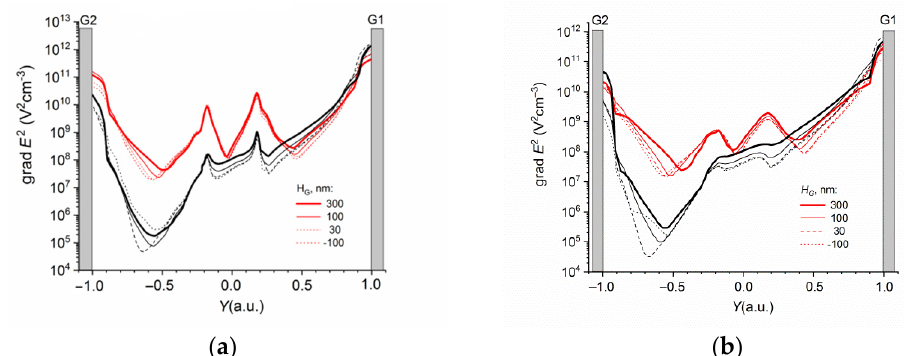
Figure 5. Dependencies of grad E 2 (Y) calculated at the distance from the BOX of Z , nm: ( a ) 30, ( b ) 100 in the cross sections of B for sensors with different DEP-2 electrode heights H G . V bg = ‒ 0.5 V (black lines) and V bg = 0.5 V (red lines). L = 1.2 mkm.